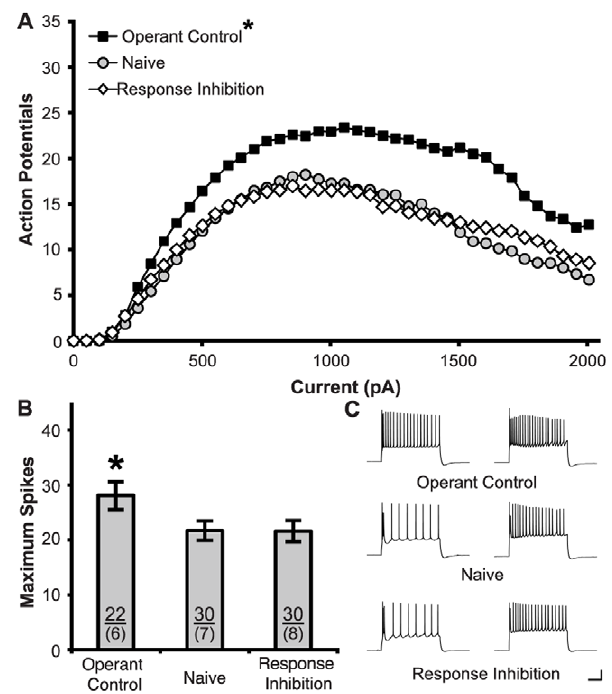
Figure 4. Training on the Operant Control condition increased the intrinsic excitability of infralimbic neurons. A. Action potentials were produced by increasing current steps (800 ms, 50 pA steps). Subjects in the Operant Control condition exhibited greater spiking than those in the RI and Naı¨ve conditions. B. Learning the Operant Control task increased the maximum number of action potentials evoked. Sample sizes for subjects (above) and cells (below) are indicated within the bars. C. Representative traces show action potentials generated by 500 pA (left) and 1000 pA (right) current steps for RI, Operant Control, and Naı¨ve subjects. (Calibration Bars: 20 mV/ 0.1 s; * : p , 0.05 vs. all groups).